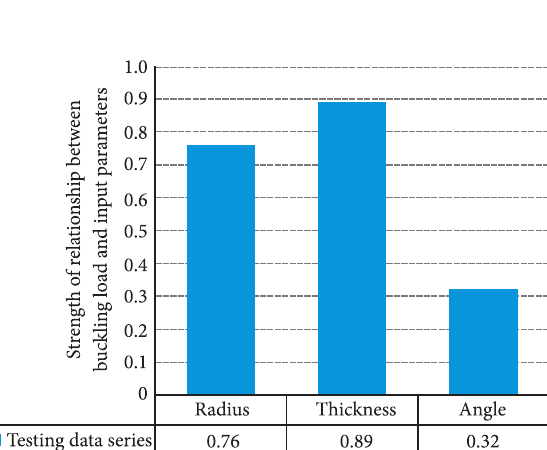
Fig. 5. The buckling mode shapes of arch-shells from the 1 st to the 5 th